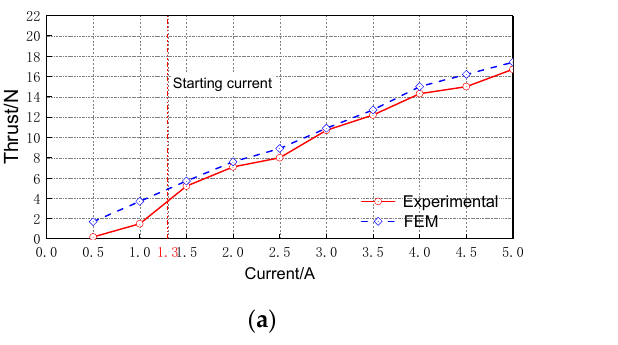
Figure 18. Electromagnetic thrust: ( a ) Unilateral electromagnetic thrust; ( b ) Bilateral electromagnetic thrust.